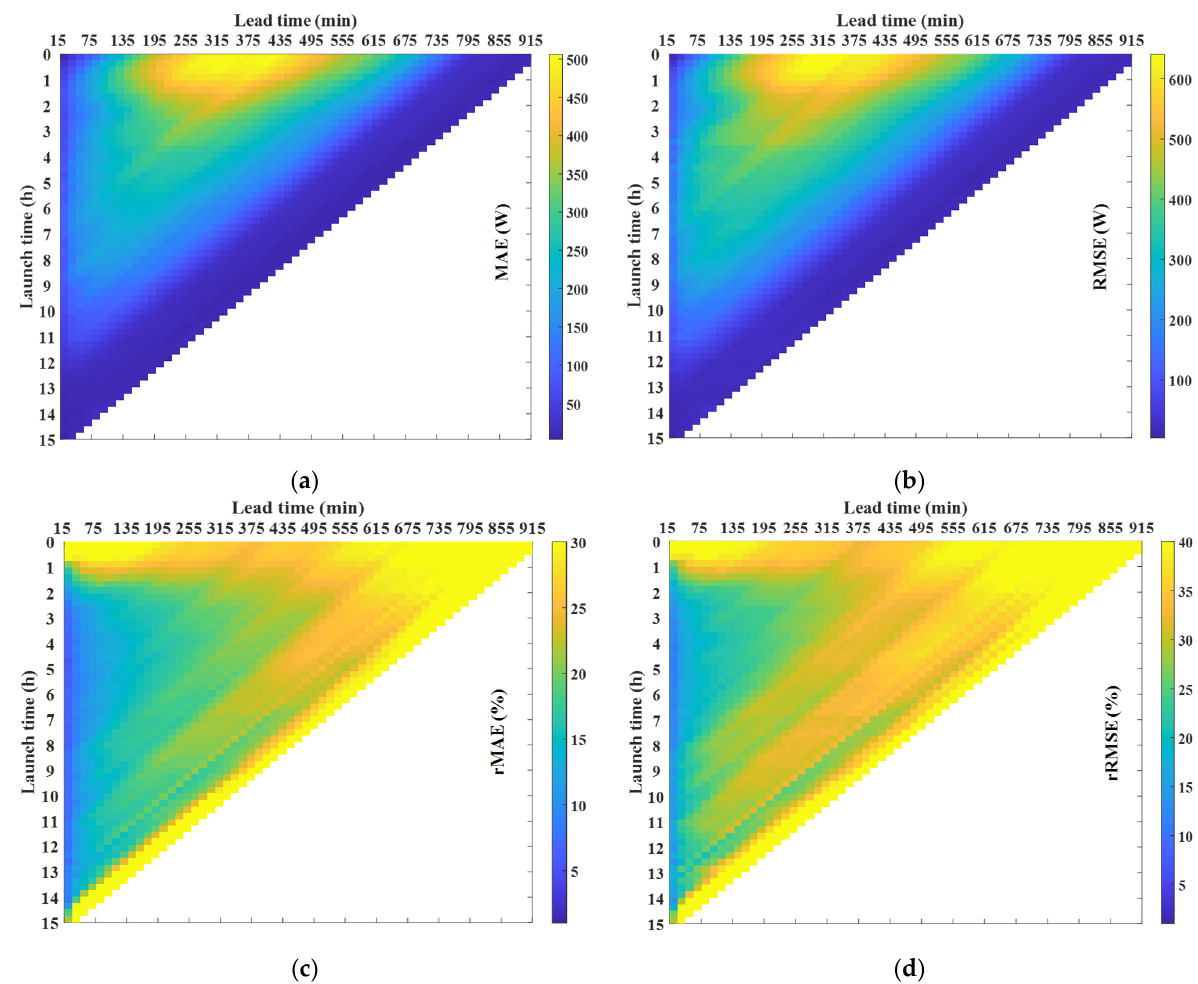
Figure 9. Error matrices obtained from PV power real measurements and PV power estimated values, as a function of the launch time and the lead time: ( a ) MAE; ( b ) RMSE; ( c ) rMAE; and ( d ) rRMSE.